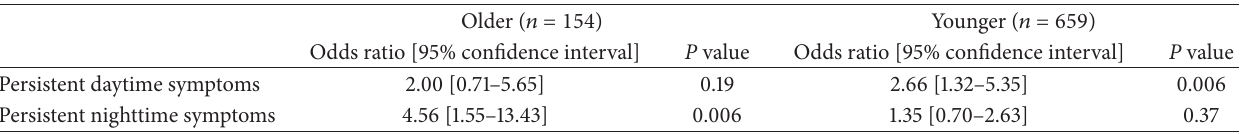
Table 8: Multivariate associations of persistent daytime and nighttime asthma symptoms with OSA (clinically-diagnosed and untreated) with adjustment for age, gender, race (African-American versus. all others), rhinitis, chronic sinusitis, nasal polyps, gastroesophageal reflux disease, and psychiatric disease, in the older and younger asthma